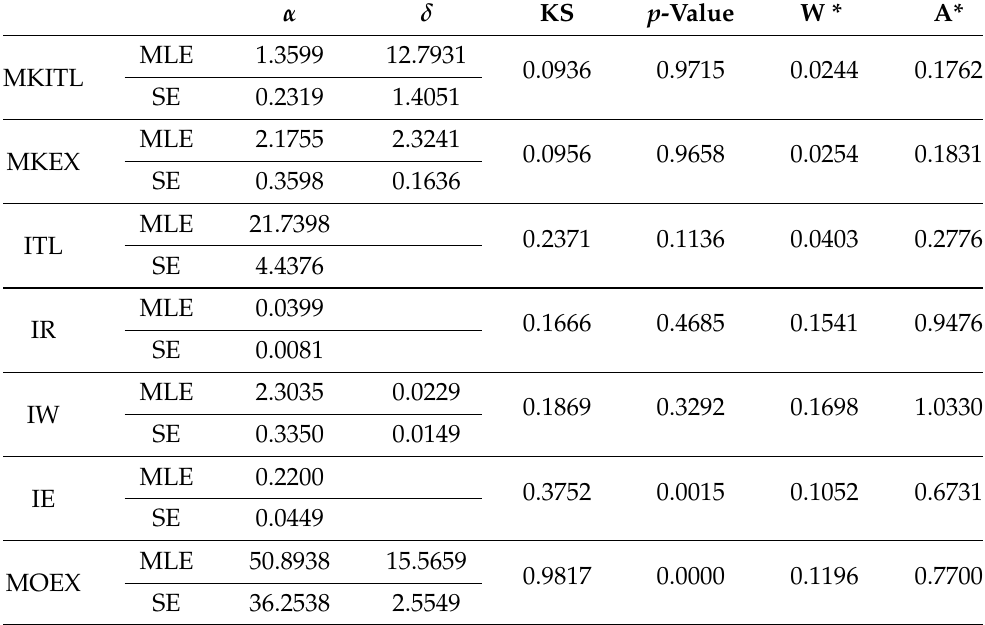
Table 5. MLE, SE, KS test and P -values for COVID-19 data of The United